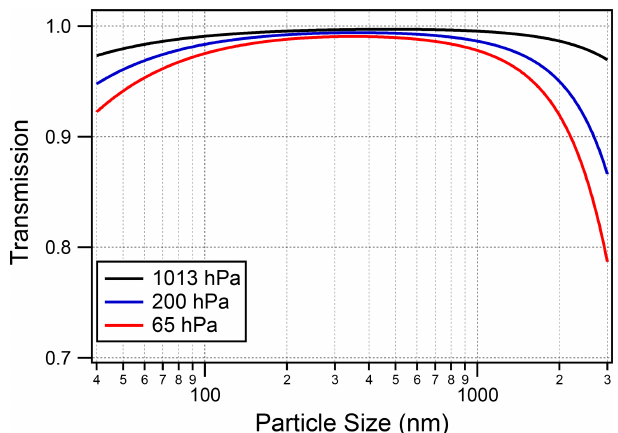
Figure 3. Calculated particle transmission of the aerosol sampling line versus aerosol particle diameter, at three different pressures in- side the